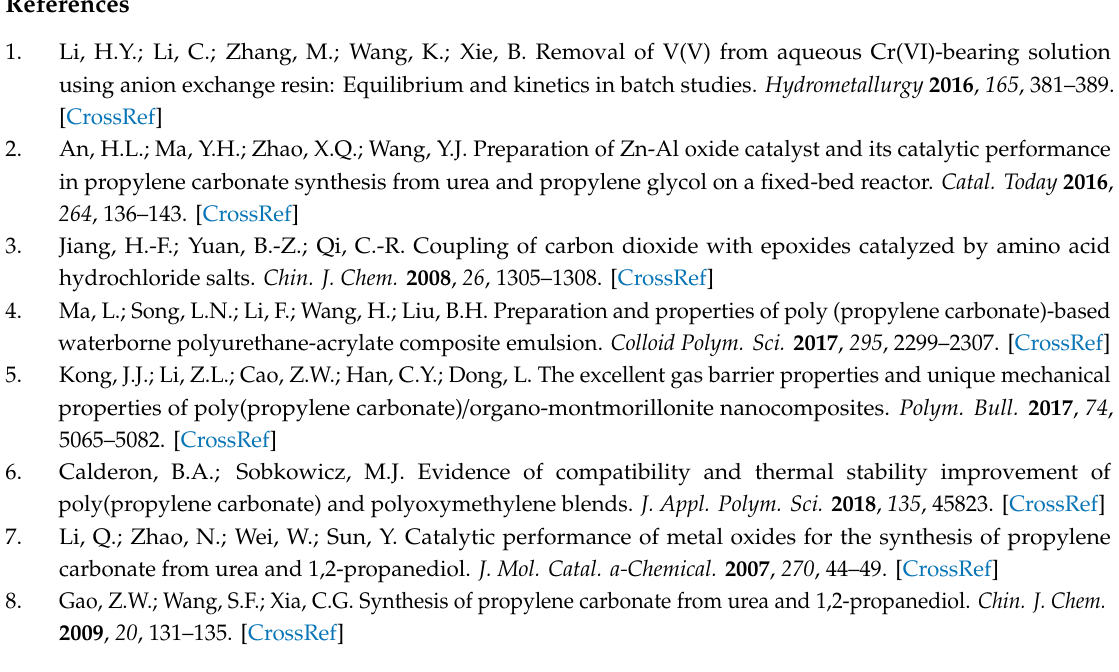
Figure S1. SEM of (A) SMgAlO-1; (B) SMgAlO-3; and (C) SMgAlO-7; Figure S2. N 2 adsorption and desorption isotherms (77K) for MgAlO (blue), SMgAlO-1 (black), SMgAlO-3 (green), SMgAlO-5 (red), and SMgAlO-7 (magenta); Table S1. The properties of probes; Table S2. The retention time, Vn, and RTlnVn of the MgAlO catalyst at various temperatures; Table S3. γ d s / mJ · m − 2 values of the MgAlO catalyst versus temperature; Table S4. Adsorption free energy and adsorption enthalpy of polar probes on the surface of the MgAlO catalyst; Table S5. The retention time, Vn, and RTlnVn of SMgAlO-1 catalyst at various temperatures; Table S6. γ d s / mJ · m − 2 values of SMgAlO-1 catalyst versus temperature; Table S7. Adsorption free energy and adsorption enthalpy of polar probes on the surface of SMgAlO-1 catalyst; Table S8. The retention time, Vn, and RTlnVn of the SMgAlO-3 catalyst at various temperatures; Table S9. γ d s / mJ · m − 2 values of the SMgAlO-3 catalyst versus temperature; Table S10. Adsorption free energy and adsorption enthalpy of polar probes on the surface of the SMgAlO-3 catalyst; Table S11. The retention time, Vn, and RTlnVn of SMgAlO-5 catalyst at various temperatures; Table S12. γ d s / mJ · m − 2 values of SMgAlO-5 catalyst versus temperature; Table S13. Adsorption free energy and adsorption enthalpy of polar probes on the surface of SMgAlO-5 catalyst; Table S14. The retention time, Vn, and RTlnVn of the SMgAlO-7 catalyst at various temperatures; Table S15. γ d s / mJ · m − 2 values of the SMgAlO-7 catalyst versus temperature; Table S16. Adsorption free energy and adsorption enthalpy of polar probes on the surface of the SMgAlO-7